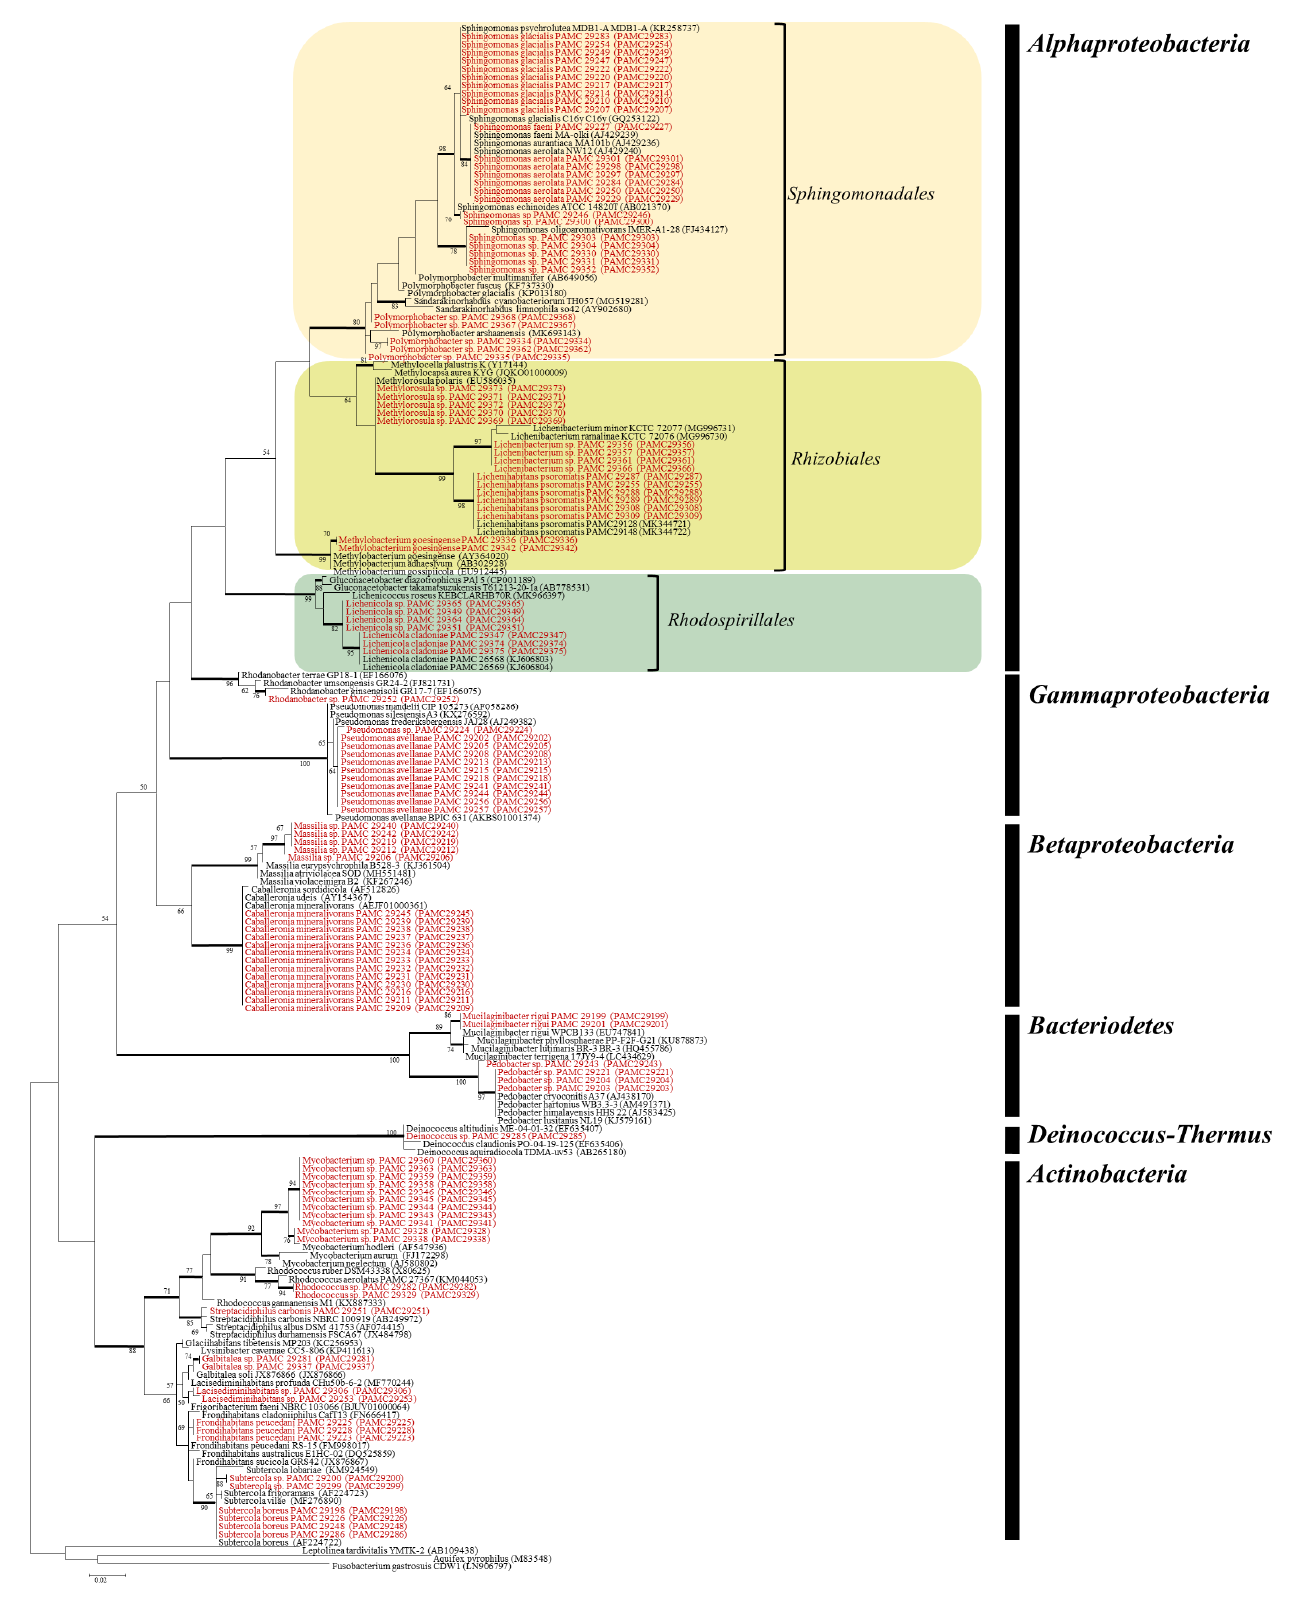
Figure 1. Maximum likelihood tree of isolates with closely related reference species based on 16S rRNA gene sequences. Representative isolates for each phylotype are indicated by bold letters. Branches supported by high bootstrap values (>70%) are shown as thick